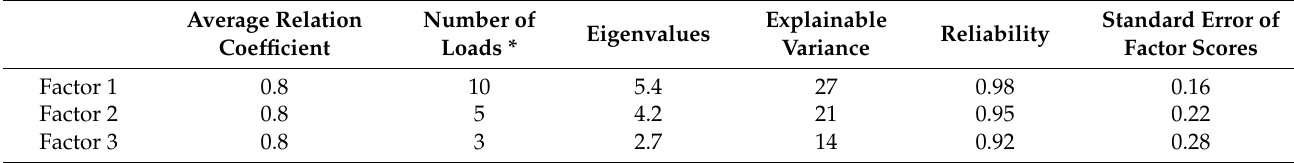
Table 9. General factor